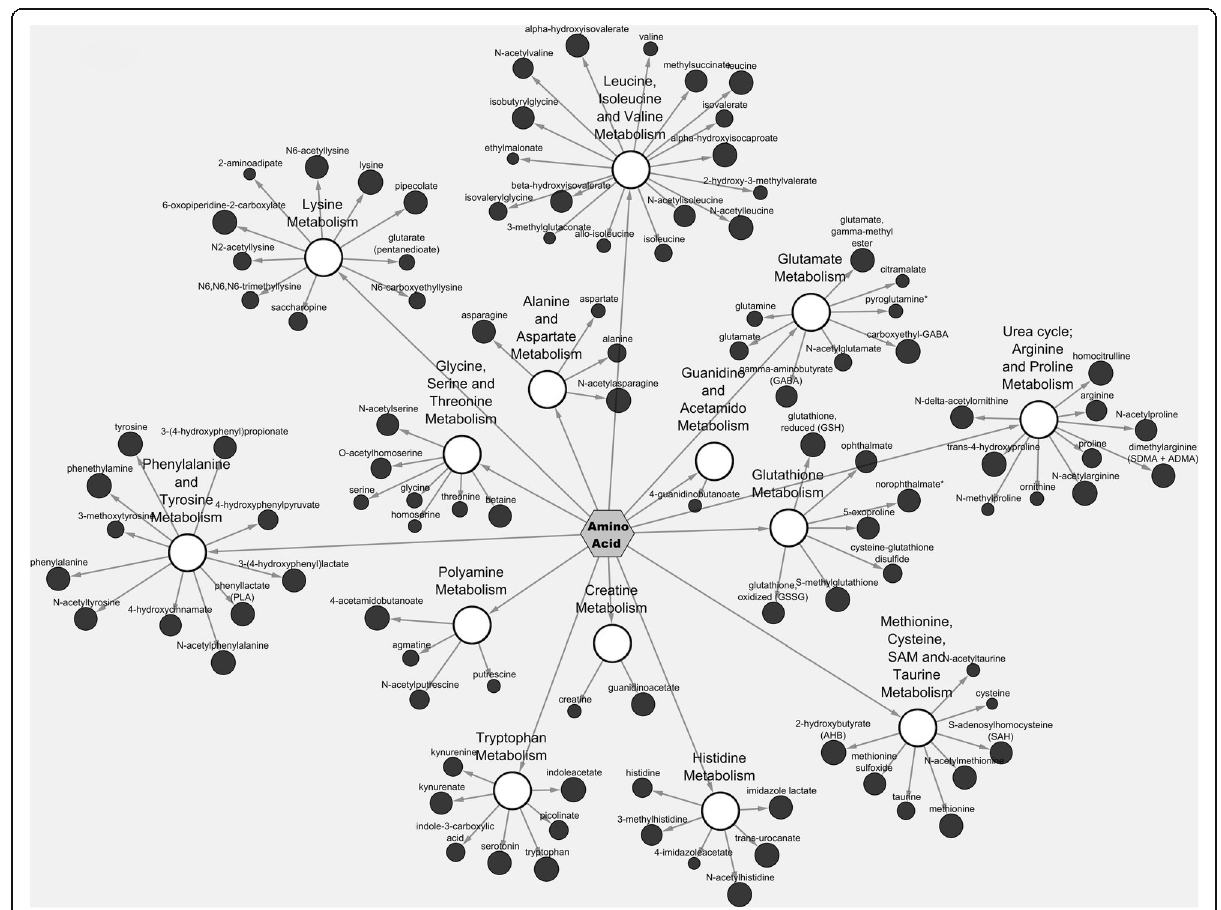
Fig. 1 Cytoscape network analysis of rice bran amino acid metabolic pathways. Pathway specific network visualization is shown for Calrose rice bran. Each metabolite is represented as a node (circle), extending from a central sub-metabolic pathway node. The central hexagon represents the super metabolic pathway. Node size corresponds to the Z-score using the relative abundance mean value for all three